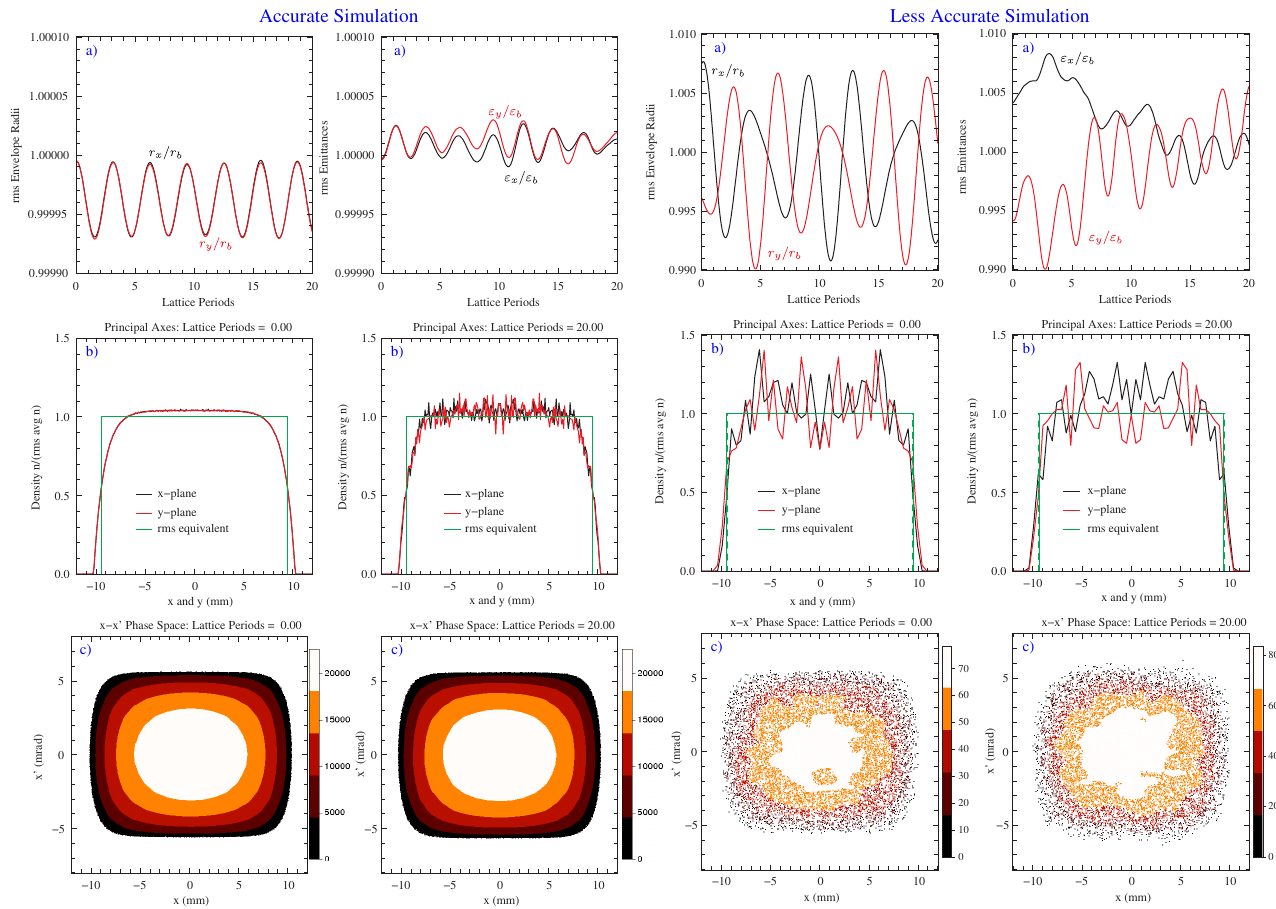
¼ 80 (cid:5) and FIG. 2. (Color) PIC simulations of an initial waterbag equilibrium distribution in a continuous-focusing channel with (cid:3) 0 ¼ 0 : 2 for a well-converged (two left columns; N ¼ 100 , N ¼ 500 ) and a less-converged simulation (two right columns: (cid:3)=(cid:3) r 0 ppg ¼ 20 , N ¼ 40 ). In row (a) the evolutions of rms-envelope radii [ r ð s ¼ 0 Þ ] and rms-edge emittances [ " ð s ¼ 0 Þ ] are =r =" N r j j j j ppg shown as a function of lattice periods ( s=L ). In rows (b) and (c), the principal axis beam density profiles and x - x 0 phase-space p ¼ 3 and N ¼ 25 projections are shown at zero (load) and 20 lattice periods. ( WARP simulations with parameters: N p s beam density n are shown along the x and y axes (in black and red, respectively) as calculated from the gridded charge density in the simulation with no additional smoothing. The density is normalized by the rms average Þ , so values not equal to unity indicate r measure, (cid:4)= ð q(cid:6)r x y deviations from an rms-equivalent KV beam. Density pro- file plots are superimposed with the density of an rms- equivalent KV beam (in green, with unit density as nor- malized). The x - x 0 phase-space projections are generated by plotting macroparticle markers that are color coded based on the local phase-space density. All macroparticles are shown in the projections of the less accurate simulation,